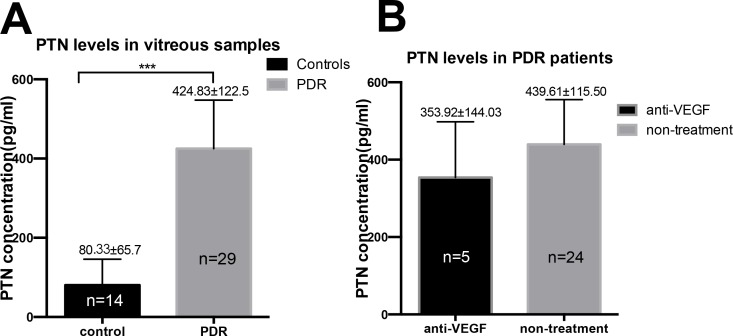
Concentration of PTN in the vitreous body from patients.Panel A shows the statistical results of PTN levels in vitreous samples from patients with non-diabetic retinopathy (idiopathic macular hole or idiopathic EMM) and from patients with PDR. PTN expression is significantly higher in the PDR group than that in the non-diabetic control group. Panel B shows the comparison results of the intravitreous PTN concentrations from patients with PDR who underwent anti-VEGF therapy or non-treatment before vitrectomy. The PTN concentration was not affected by the anti-VEGF treatment. Data are presented as the means ± SD (***P < 0.001).